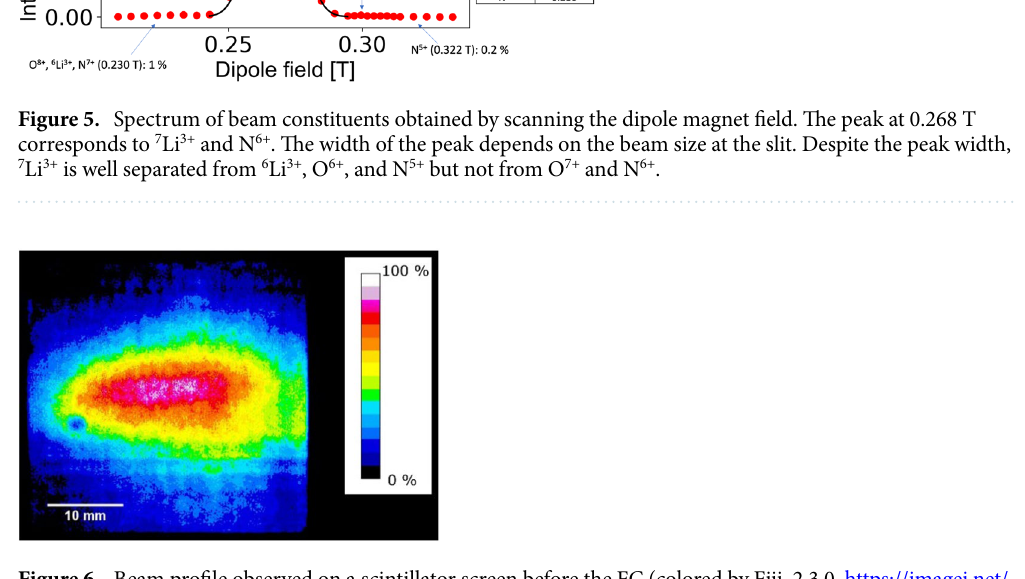
Figure 6. Beam profile observed on a scintillator screen before the FC (colored by Fiji, 2.3.0, https:// imagej. net/ softw are/ fiji/). The magnetic field of the analyzing dipole magnet was set to guide the Li 3+ ion beam accelerated to the RFQ design energy. The blue spot in the green area is due to a defective scintillator